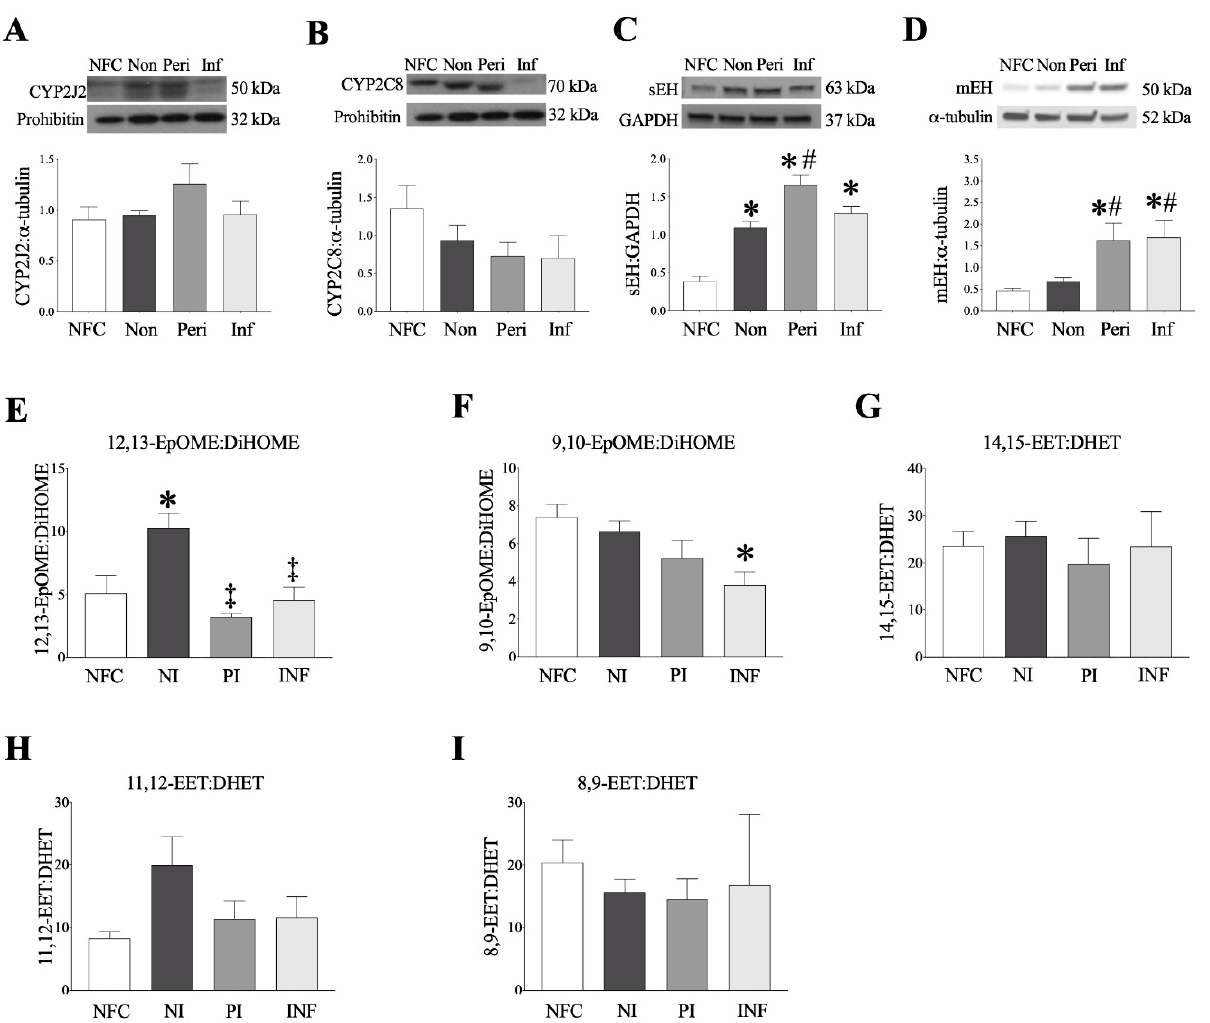
Figure 1. Epoxide hydrolase, cytochrome P450 expression and oxylipid metabolites in human left ventricular tissue. ( A ) CYP2J2, ( B ) CYP2C8, ( C ) soluble epoxide hydrolase (she) and ( D ) microsomal epoxide hydrolase (mEH) expression in non-failing control and myocardial infarction (MI) female hearts. CYP2J2 and CYP2C8 were normalized to prohibitin, sEH was normalized to GAPDH, and mEH normalized to α -tubulin. ( E – I ) Oxylipid metabolites in human left ventricle (LV) tissue (ng/g tissue) as measured by LC–MS/MS. ( E ) 12,13-EpOME:DiHOME ratios, ( F ) 9,10-EpOME:DiHOME ratios, ( G ) 14,15-EET:DHET ratios, ( H ) 11,12-EET:DHET ratios, ( I ) 8,9-EET:DHET ratios. Data are shown as mean ± SEM, N = 3–5. In all cases, p ≤ 0.05, * vs control group; # vs. wild-type (WT) group; ‡ vs. non-infarct.